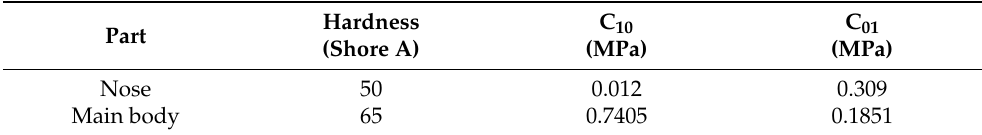
Table 7. Parameters of the GINA gasket constitutive model. Hardness Part